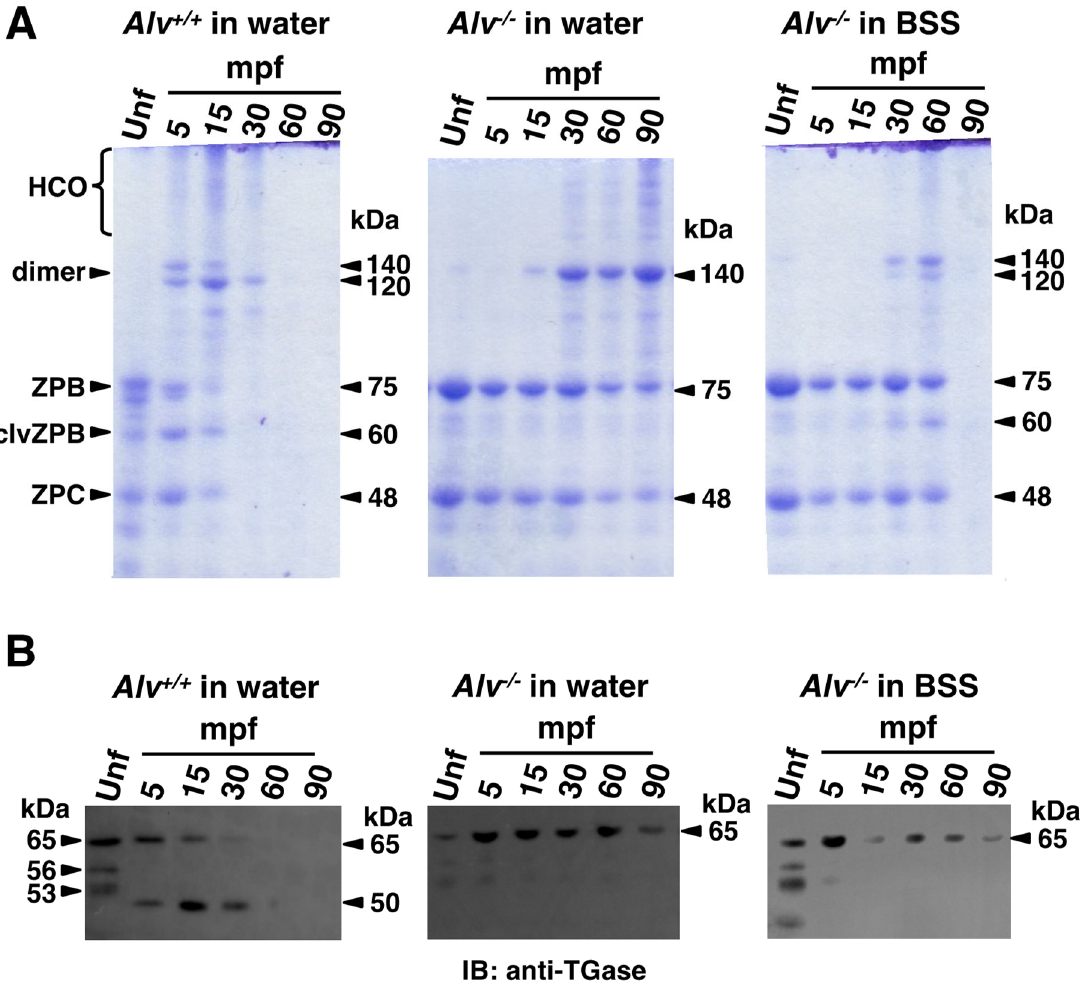
Figure 7. Time-dependent changes of chorion components after fertilization. ( A ) SDS-PAGE/CBB staining of the chorions isolated from the unfertilized eggs (Unf) and the fertilized eggs at 5, 15, 30, 60, and 90 min post ‐ fertilization. Alv +/+ in water, Alv +/+ eggs fertilized and incubated in water; Alv − / − in water and Alv − / − in BSS, Alv − / − eggs fertilized and incubated in water and in BSS, respectively. ZPB (75 kDa), cleaved ZPB (60 kDa), and ZPC (48 kDa) were assigned as described in the text. ( B ) Western blotting of the chorion preparations as described in ( A ), using anti ‐ hardening transglutaminase (TGase) antibody. Hardening TGase (65 kDa) and the processed TGase (50 kDa) are assigned as described in the text.